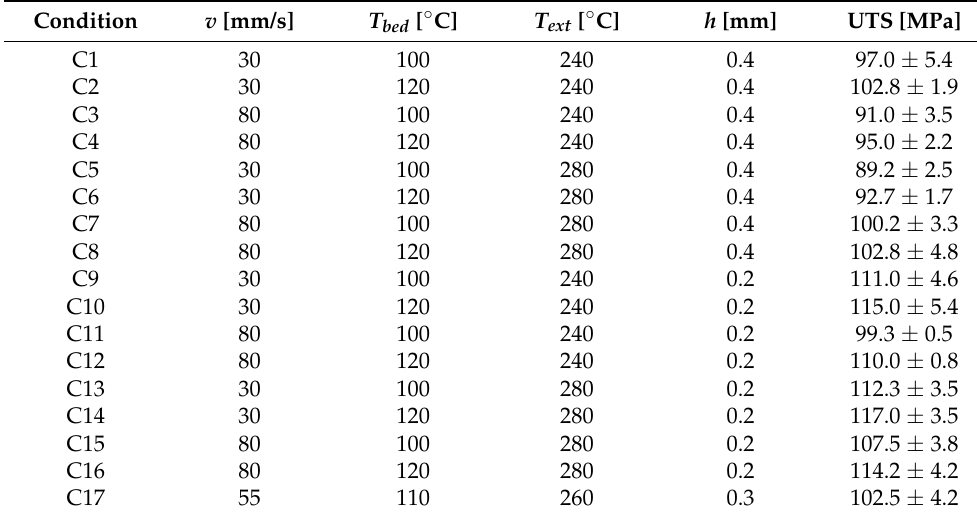
Table 2. Average UTS values for each condition within the DoE.